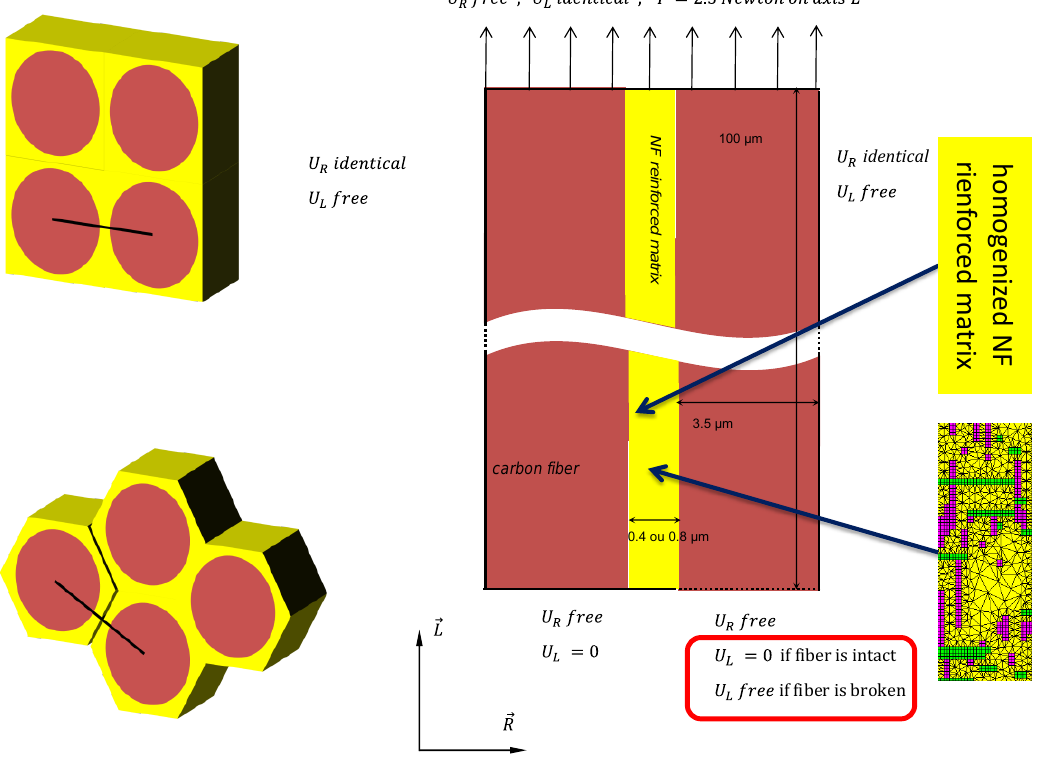
Figure 1. General characteristics of the model used for the study of load transfer between neighboring